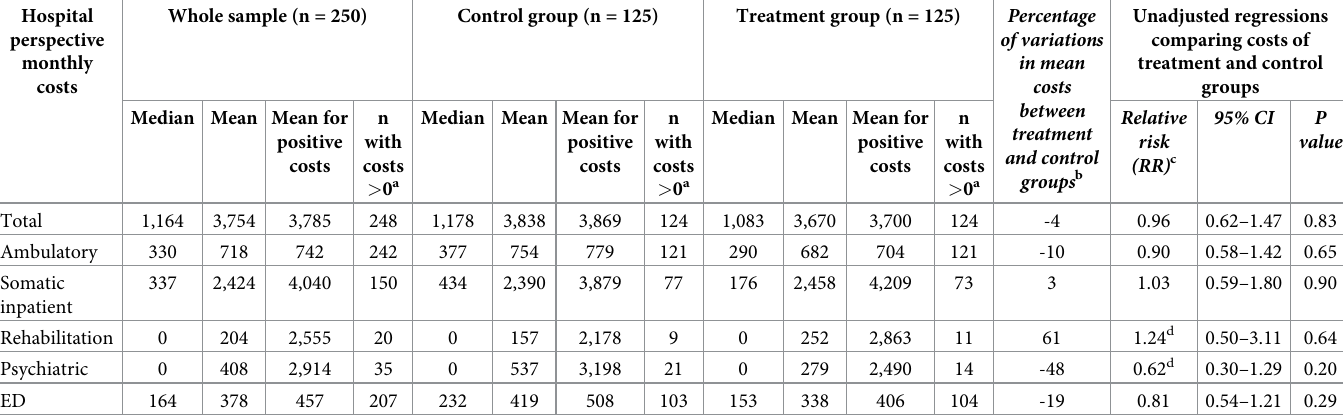
Table 2. Cost data from the hospital perspective for the whole sample, the control group, and the treatment